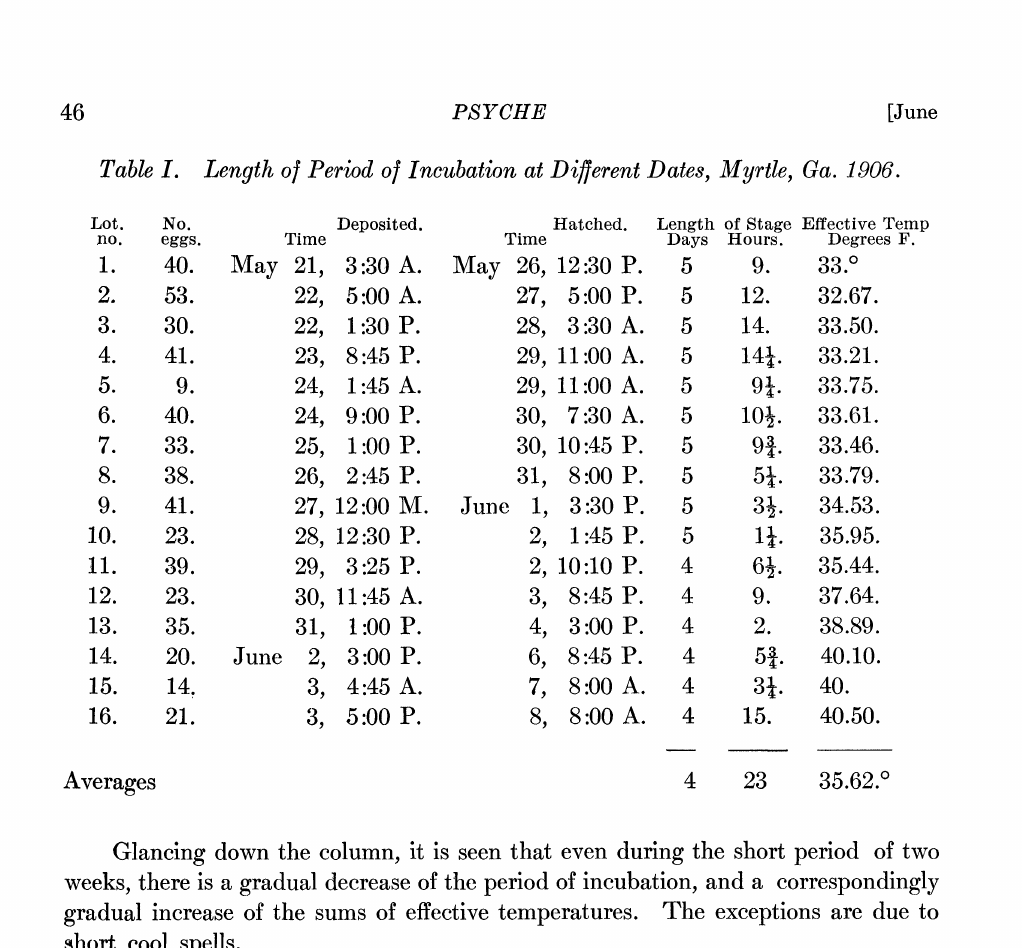
Table I. Length o] Period o] Incubation at Di]erent Dates, Myrtle, Ga. 1906.